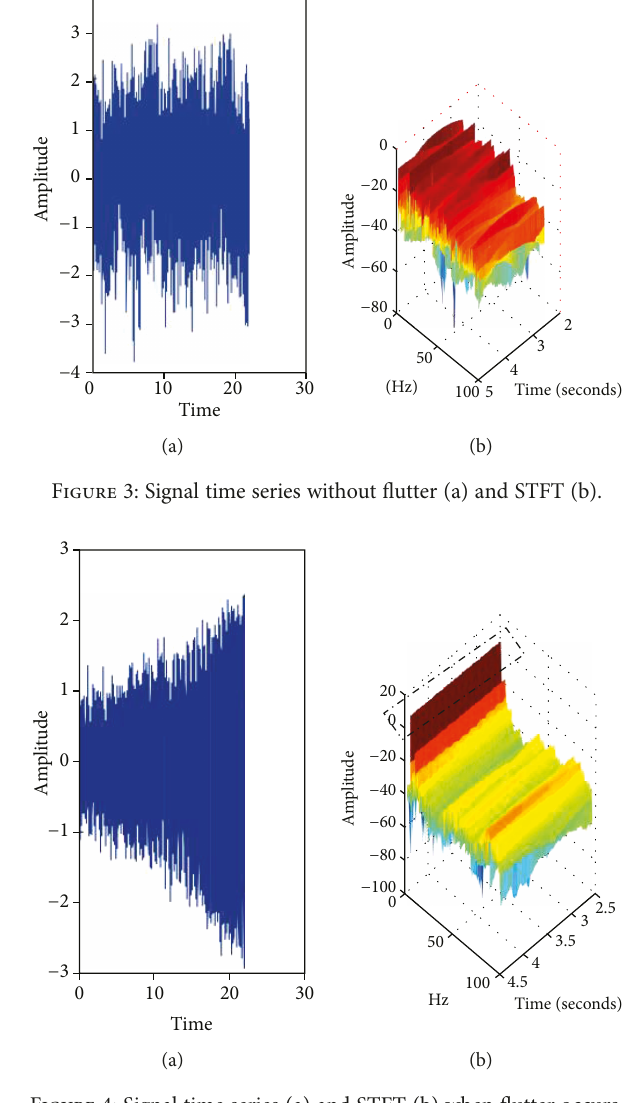
Figure 4: Signal time series (a) and STFT (b) when fl utter occurs. Table 1: 3D dataset